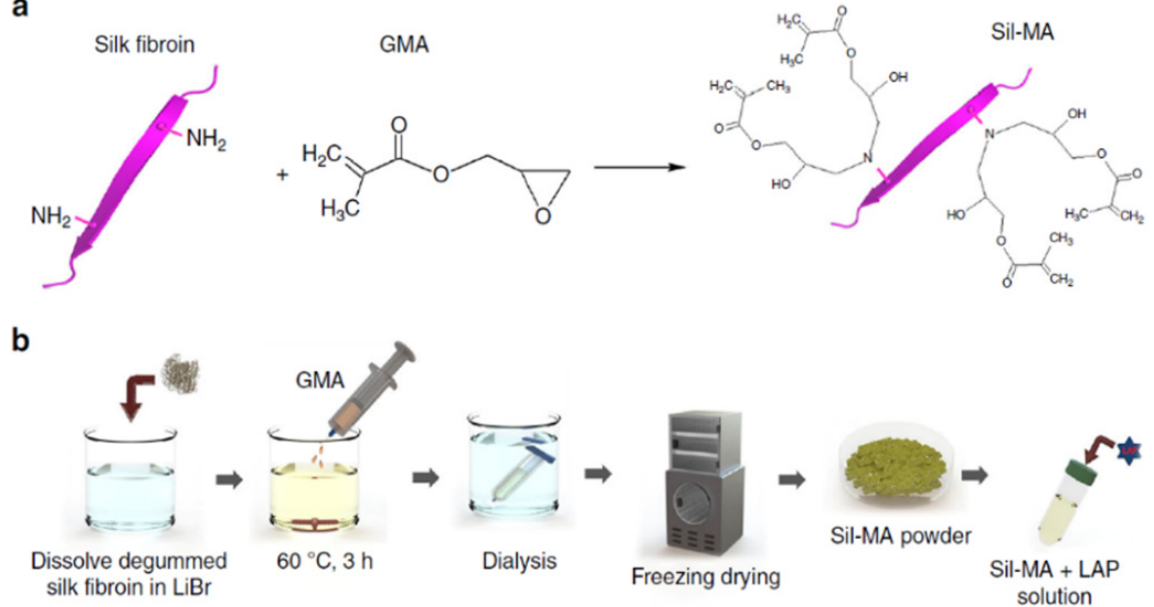
Figure 3. The fabrication process of SF bio-ink for DLP printing. ( a ) SF molecules were modified with the addition of GMA by methacrylation. ( b ) Graphical illustration of methacrylation of SF. GMA was added dropwise into the dissolved SF solution in LiBr (9.5 M) and mixed with continuous stirring at 60 °C for 3 h. Then, it was dialyzed against distilled water for 4 days and freeze-dried. Finally, LAP was put into a GMA-modified SF solution. Adapted from [43] with permission from Springer Nature.